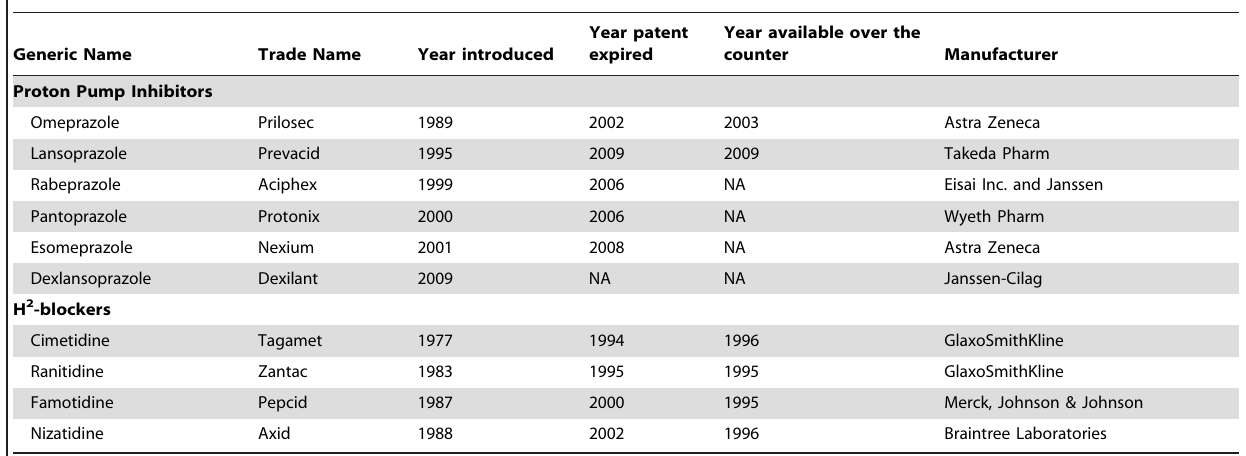
Table 1. Proton pump inhibitors and H 2 -blockers used in the